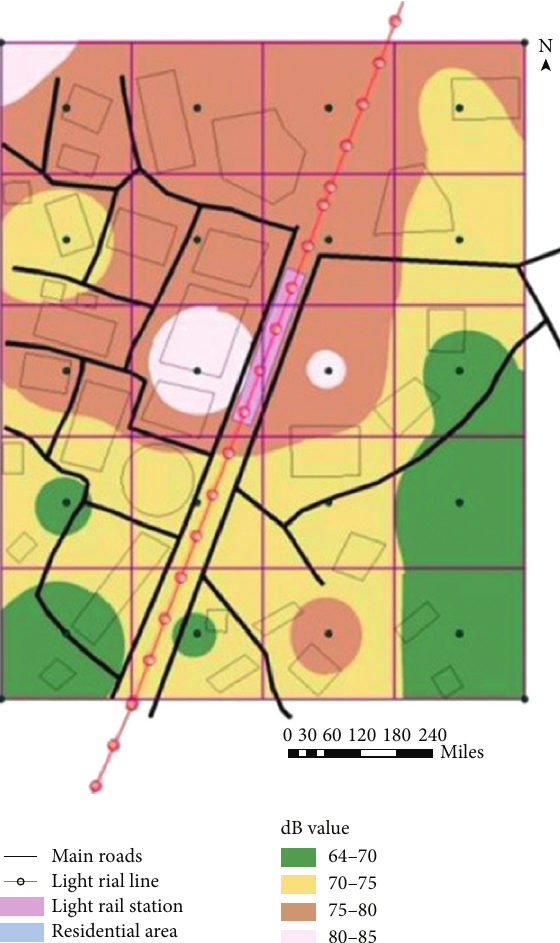
Figure 15: Acoustic environment map for the